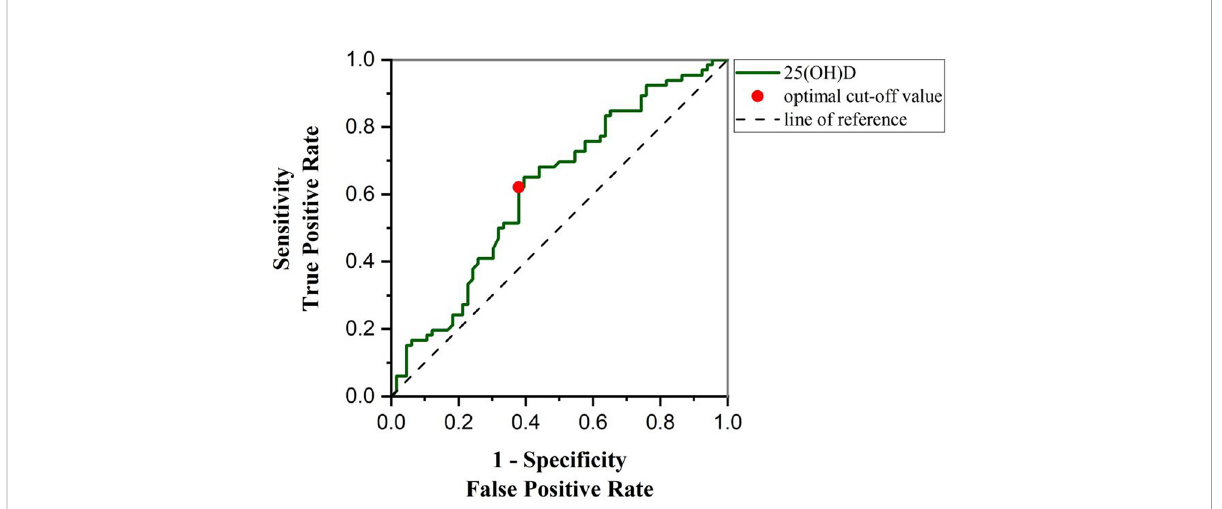
FIGURE 6 ROC curve was used to analyze the diagnostic signi fi cance of 25(OH)D level to distinguish high total scores of BRIEF-A (scores > 50th percentile) and low total scores of BRIEF-A (scores ≤ 50th percentile). 25(OH)D concentration was 28.48 ng/mL, the sensitivity and speci fi city were 62.12% and 62.12%, and the AUC value was 0.62(95% CI: 0.5252-0.7166), which could be used as the best critical point for differentiating T2DM patients with high total scores of BRIEF-A and low total scores of BRIEF-A. AUC, area under the